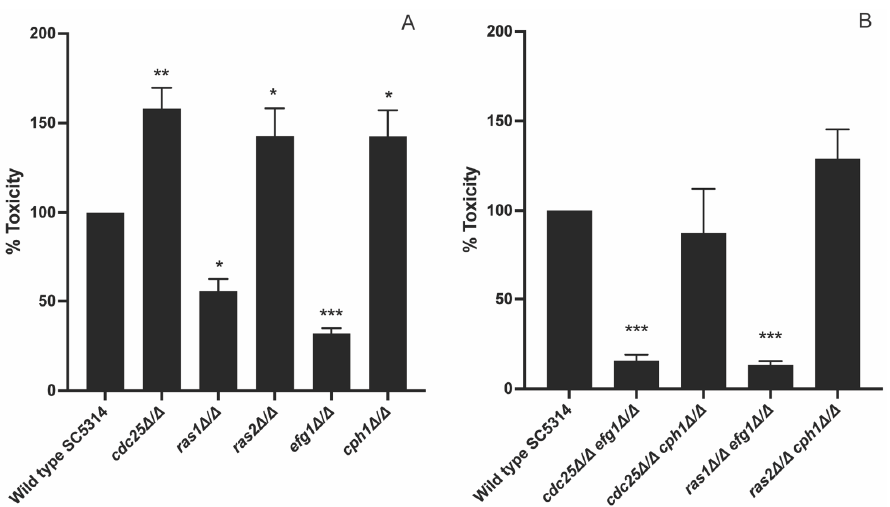
Figure 4. Efg1 has a positive effect while Cph1 has a negative effect on toxicity. HeLa cells were seeded at a concentration of 10,000 cells/well. C. albicans cells were added at OD 600 1. After an incubation of 24 h the released amount of LDH from the HeLa cells was measured. ( A ) The toxicity of the WT was compared with a cdc25 , ras1 , ras2 , efg1 , and cph1 mutant. ( B ) The toxicity of the WT was compared with a cdc25 efg1 , cdc25 cph1 , ras1 efg1 , and ras2 cph1 double mutant. The values of the deletion strains are normalized relative to the WT strain which has 100% toxicity towards HeLa cells. The results show the average of three independent experiments each consisting of one biological repeat and three technical repeats with the error bars representing the SEM. Statistical analysis as done by using an ANOVA test with Bonferroni correction. A significant difference was found when * p = 0.0332, ** p = 0.0021, and *** p = 0.0002.